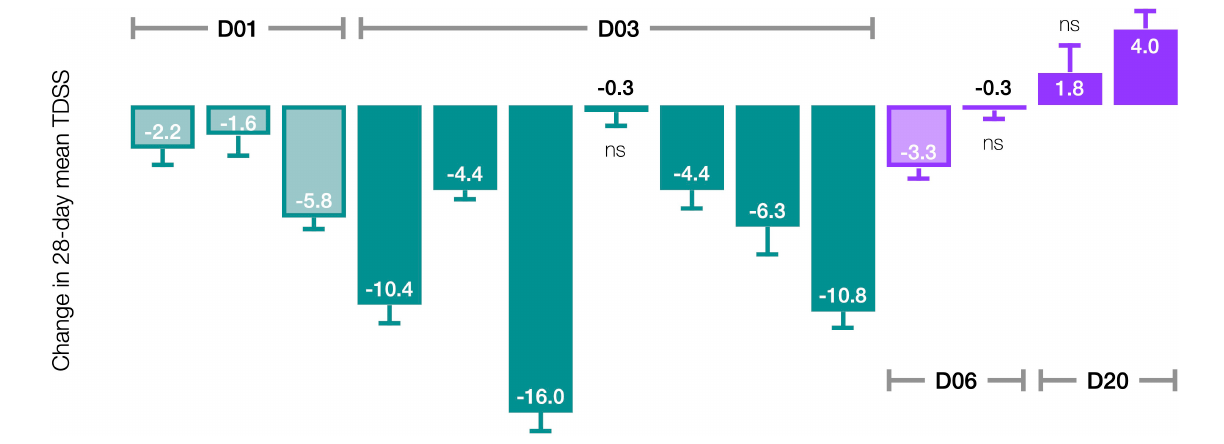
Frontiers in Systems Neuroscience |